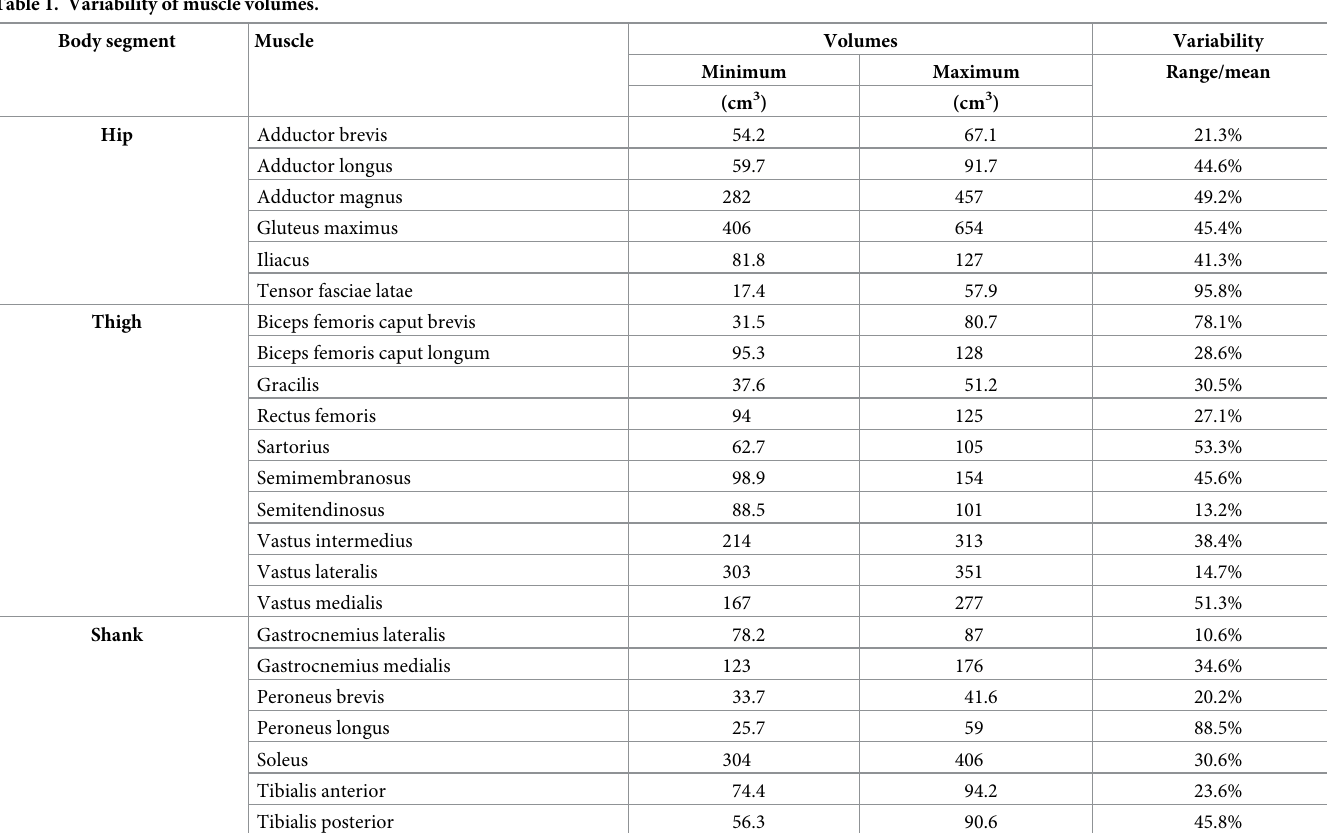
Table 1. Variability of muscle volumes.